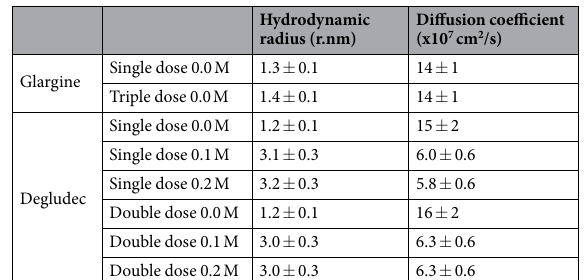
Table 1. Hydrodynamic radii and corresponding diffusion coefficients of insulins glargine and degludec, measured using dynamic light scattering.